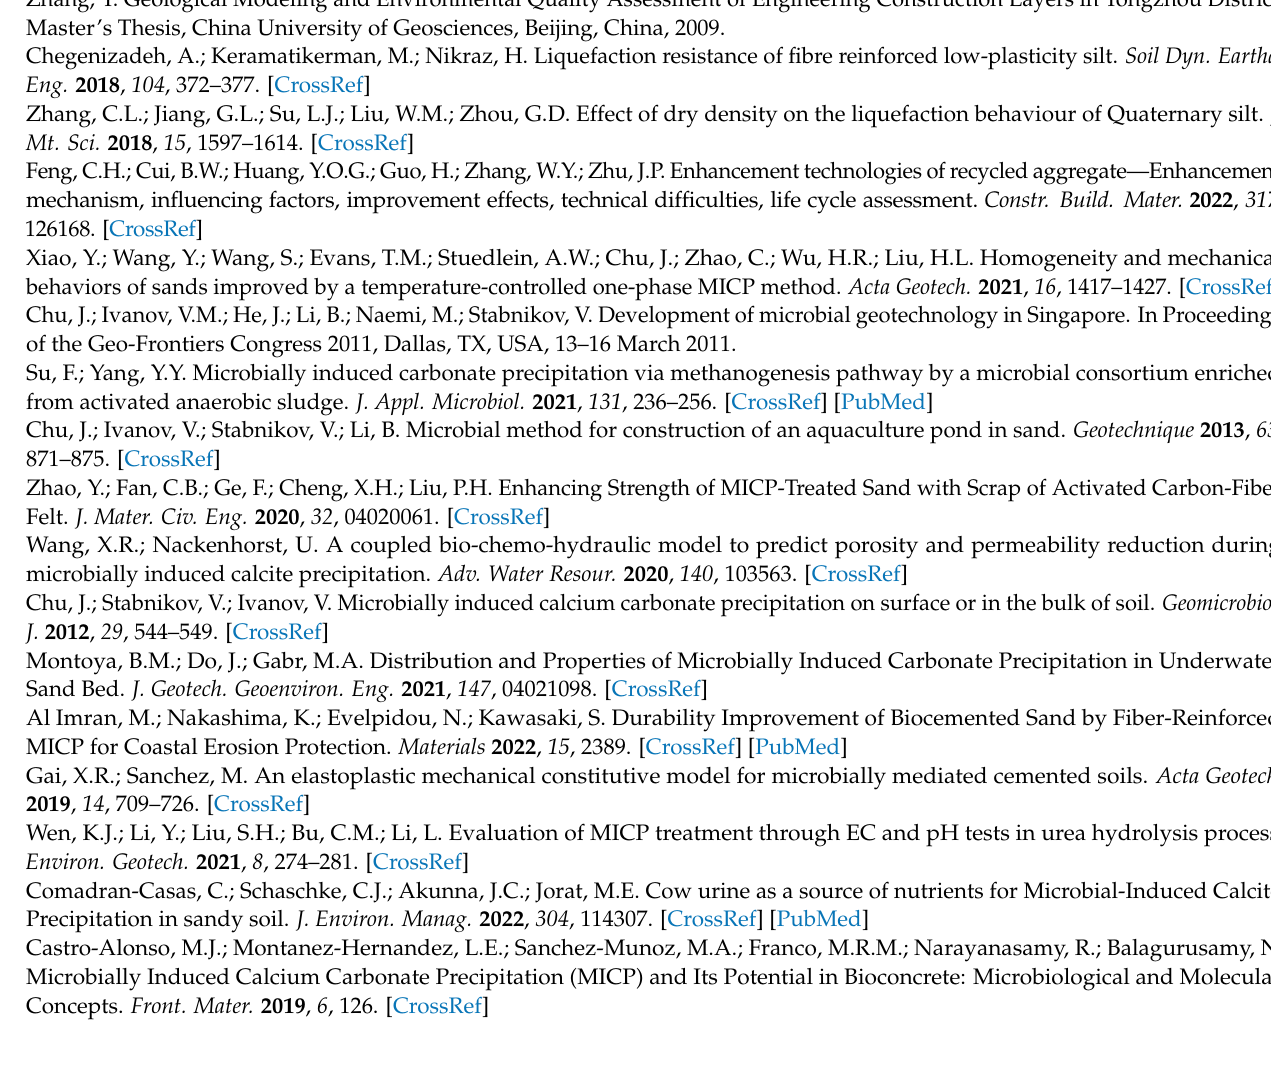
load. Table S1: Particle size ratio and coefficient. Table S2: The amount of each substance consumed in preparing a single sample. Table S3: Relationship between lignin addition ratio and